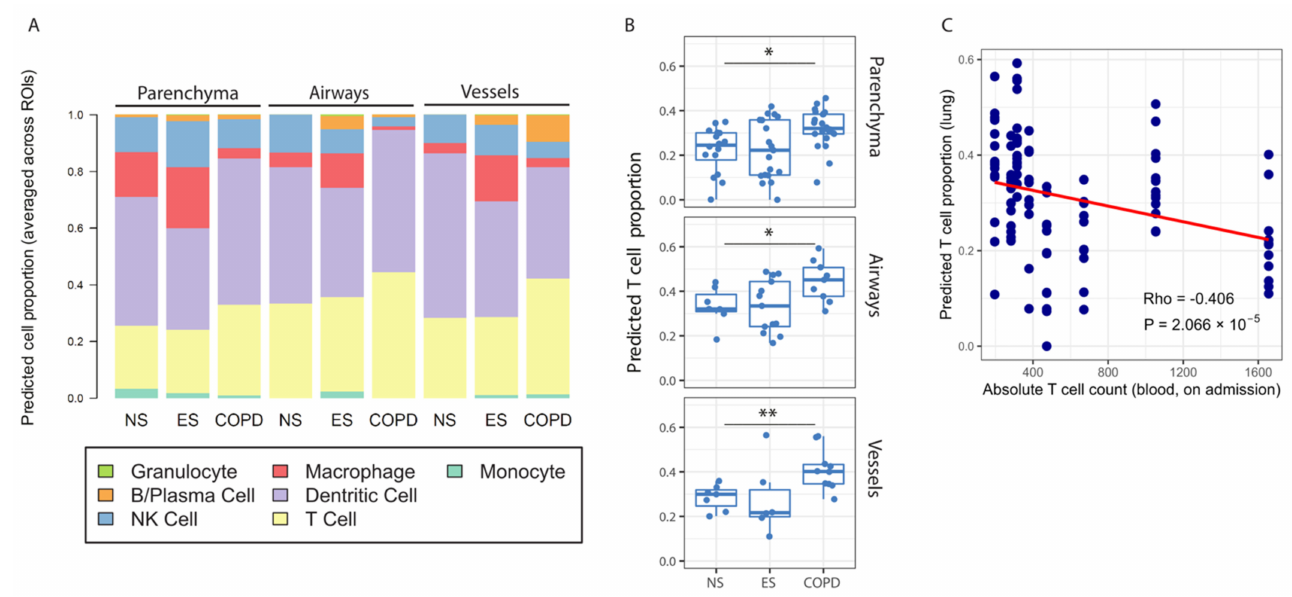
Figure 4. Deconvolution of spatial transcriptomics and T cell levels in the blood. ( A ) The cellular proportions of the immune cell types between tissue structures (parenchyma, airways, and vessels) and disease conditions (NS, ES, and COPD) were inferred using the R package “SpatialDecon”, a deconvolution method developed for the NanoString GeoMX RNA assay. ( B ) The predicted number of T cells between tissue structures (parenchyma, airways, and vessels) in never- and ever-smokers with and without COPD. ( C ) Inverse correlation between predicted cell proportion in the lung obtained by cell deconvolution and absolute T cell count in blood on admission. * Indicates p < 0.05, ** indicates p <